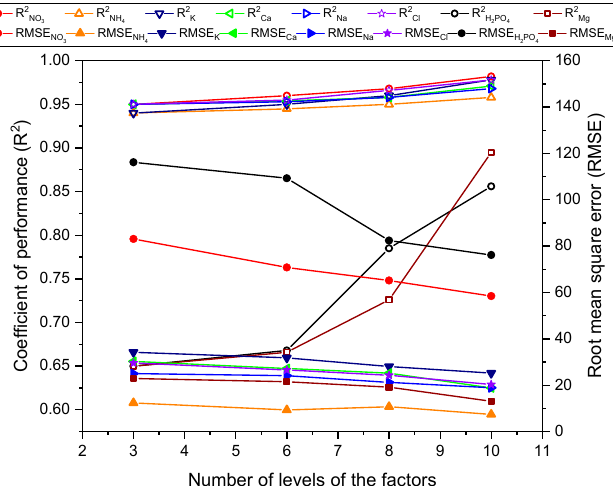
Figure 6. The performance and e ffi ciency of the DKL model with varying number of levels of factors.